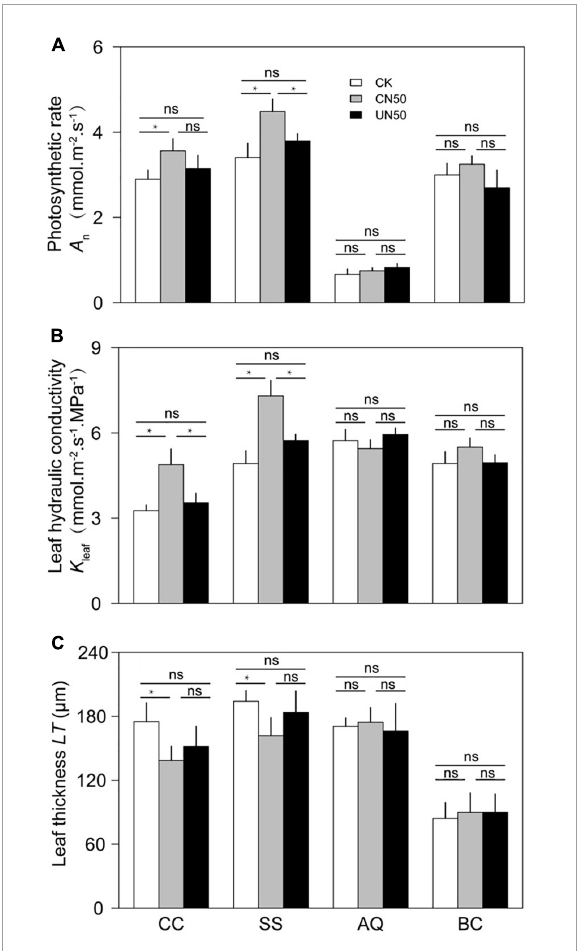
FIGURE2 Photosynthetic rate (A) , leaf hydraulic conductivity (B) , and leaf thickness (C) of two canopy tree species ( CC and SS ) and two understory species ( AQ and BC ) under control conditions (CK), canopy N addition (CN), and understory N addition (UN). CC , SS , AQ , and BC are Castanopsis chinensis , Schima superba , Ardisia quinquegona , and Blastus cochinchinensis , respectively. ns: no significant difference; *Significant difference at P < 0.05 (nested